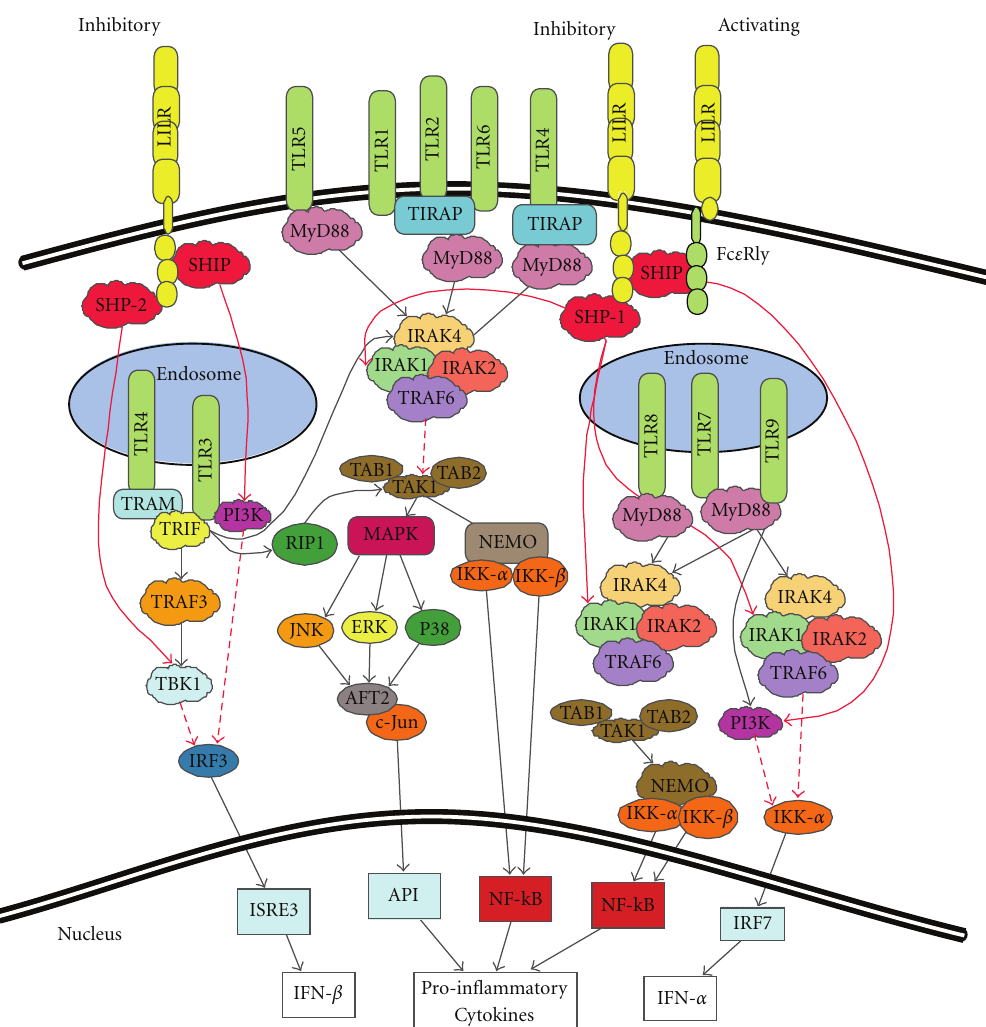
Figure 2: Possible pathways for LILR regulation of Toll-Like Receptor Signalling Pathways: There are several possible mechanisms of inhibition LILR receptors may employ to regulate TLRs. SHP-1 has been shown to associate with IRAK1 and inhibit further downstream signalling. Similarly, SHP-2 and SHIP have been shown to inhibit downstream signalling of TBK-1 and PI3K, respectively, thereby dampening down the production of proinflammatory mediators